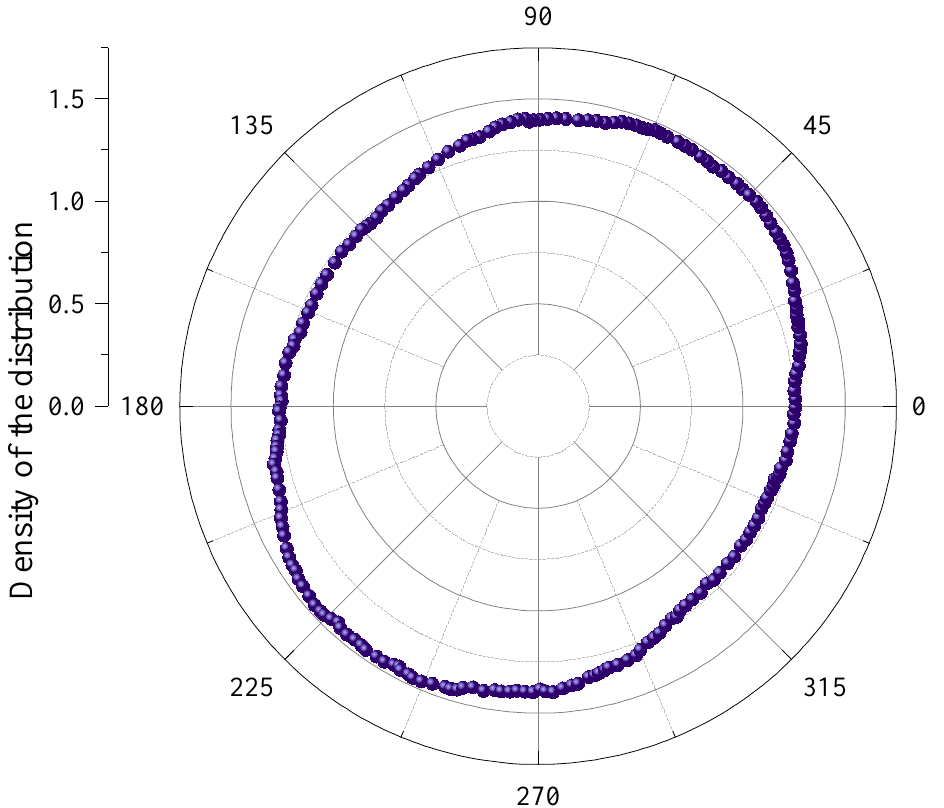
Figure 5. The relative density of the distribution of microcrystals, constructed by statistical analysis of the distribution of dark and light spots in Figure